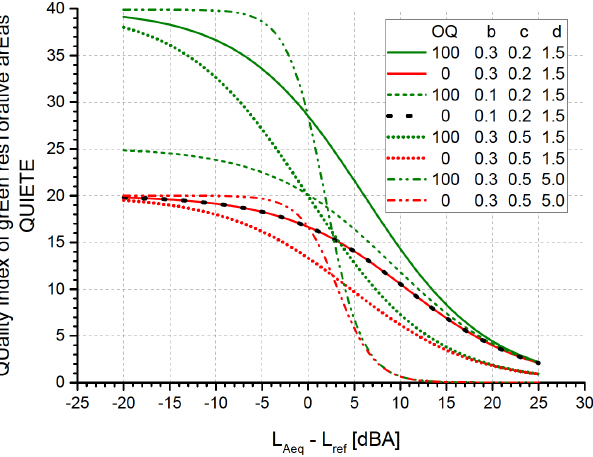
Figure 3: Sigmoid curves for OQ = 100 and 0% corresponding to different sets of values for the coeflcients b , c and d